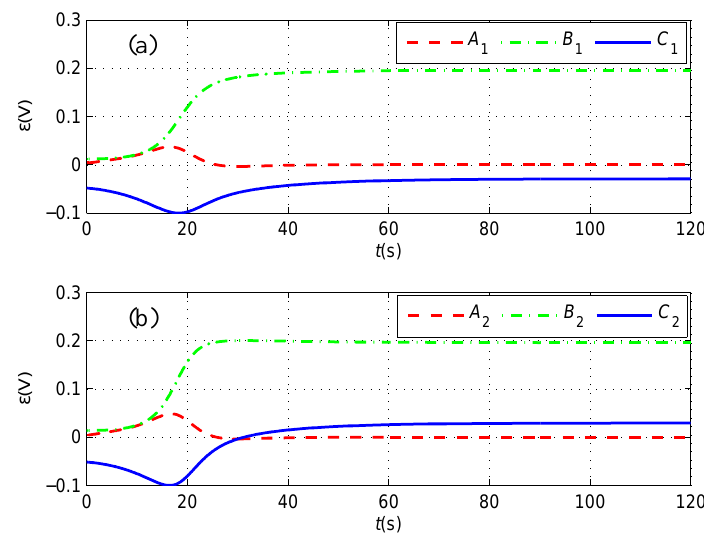
Figure 8. ( a ) The induced electromotive forces measured by the port tri-axial magnetometer; and ( b ) The induced electromotive forces measured by the starboard tri-axial magnetometer in the case of k ε = 1. The red dashed line, the green dash dotted line and the blue line represent the force components along the x -axis, y -axis and z -axis of the tri-axial magnetometer, respectively.